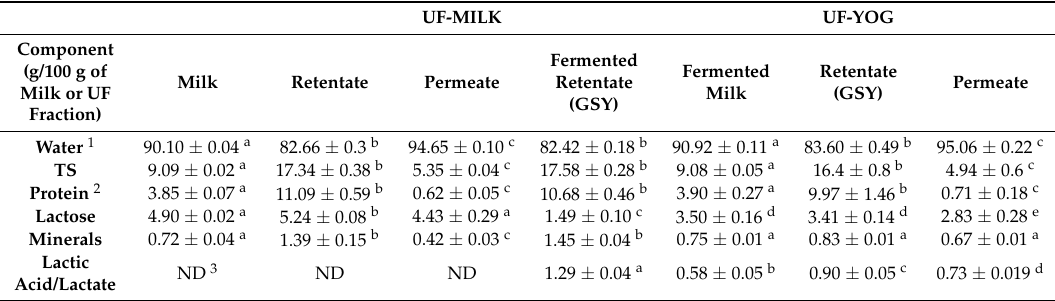
Table 2. Comparative composition of UF fractions and final composition of GSY. UF-MILK